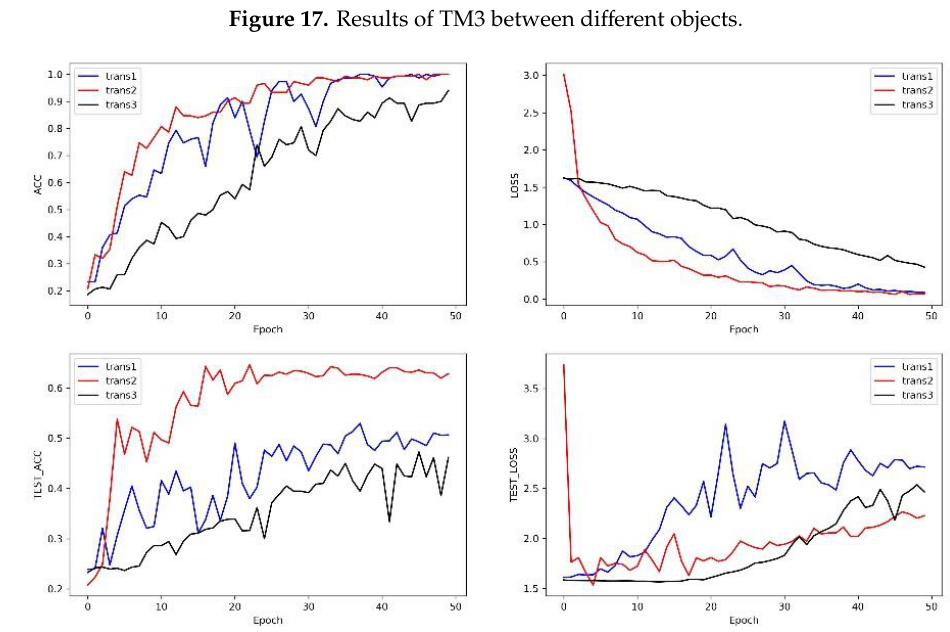
Figure 18. Comparison of three transfer methods under 0.125 data size.